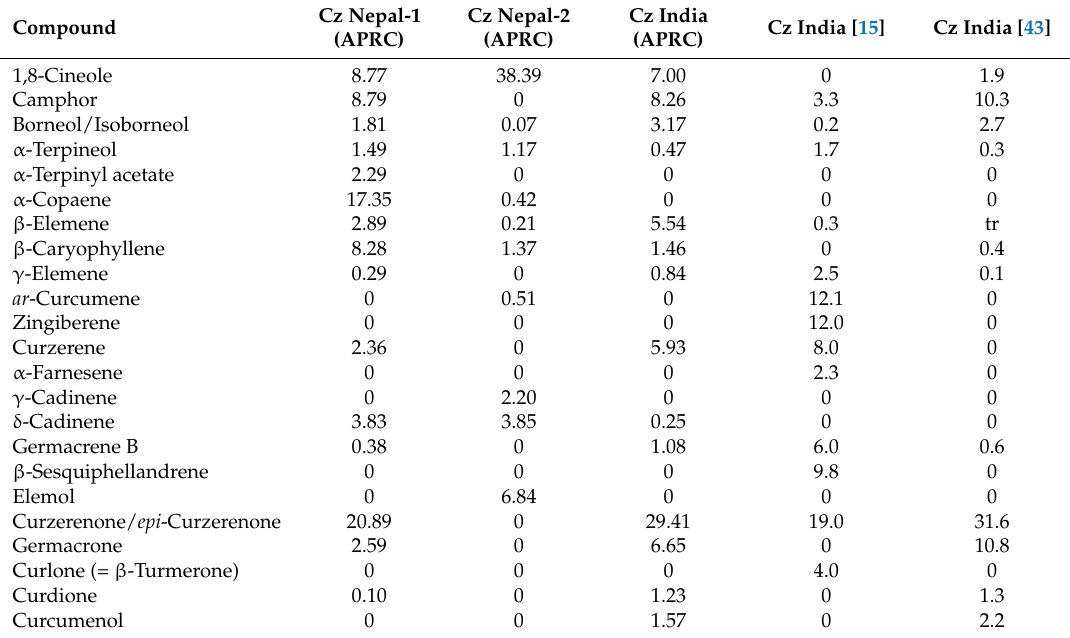
Table 3. Chemical composition of Curcuma zedoaria rhizome essential oils.